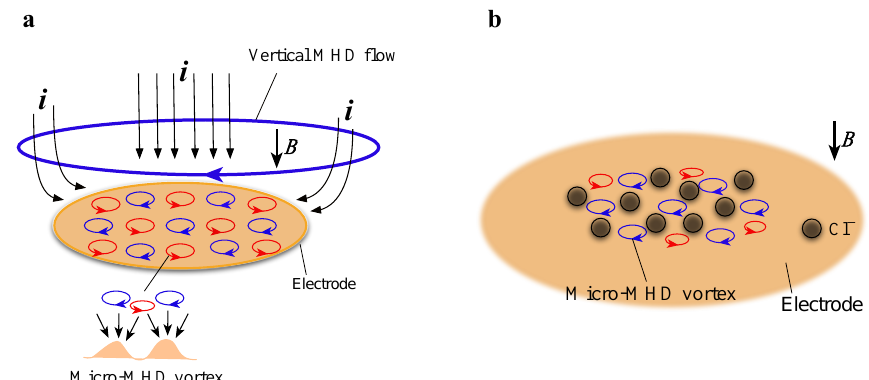
Figure 1. ( a ) Self-organized state of micro-MHD vortices under the vertical MHD flow. ( b ) Fluctuation of micro-MHD vortices in the presence of specific adsorption of chloride ions.